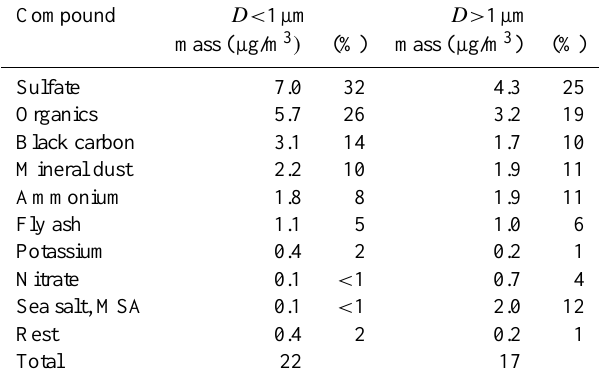
Table 6. Mean fine and coarse mass fractions of aerosols col- lected on filters on board the NCAR C-130 aircraft in the boundary layer (34 samples) and at Kaashidhoo Climate Observatory (KCO) (24 samples). D is diameter. MSA is methane sulfonic acid. “Rest” includes magnesium, calcium, oxalate, formate, and unidentified material (based on Lelieveld et al., 2001, copyright 2001 by the American Association for the Advancement of Science, reproduced with